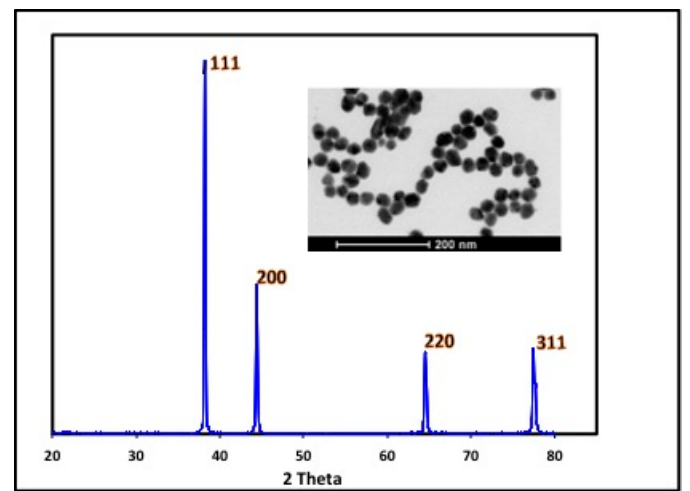
Figure 5. XRD pattern of as-synthesized silver nanoparticles produced by F. oxysporum.